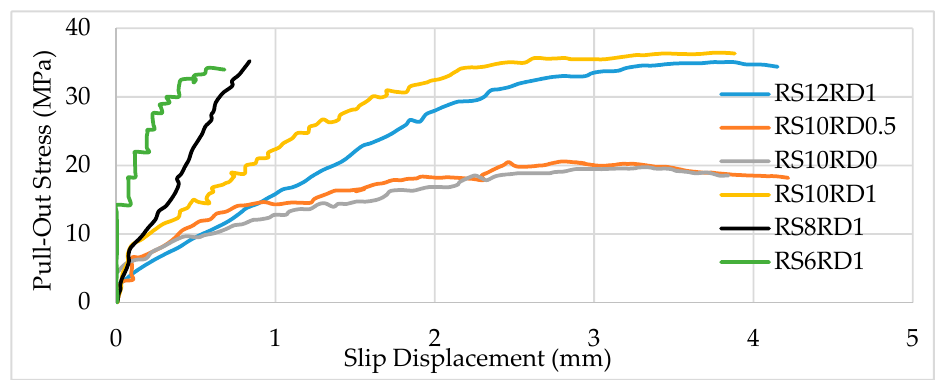
Figure 4. Pull-out stress showing stress versus slip for 10 mm diameter BFRP bars, with l = 10D and various rib spacings (RS) and rib depths (RD).